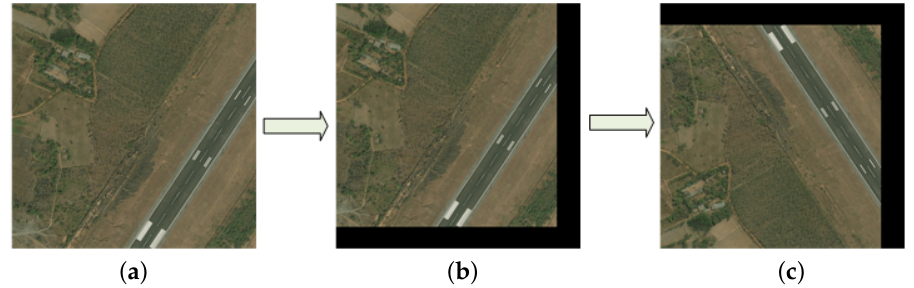
Figure 2. Samples of data augmentation adopted in this paper. ( a ) is the original image; ( b ) is the result after shifting; ( c ) is the result after